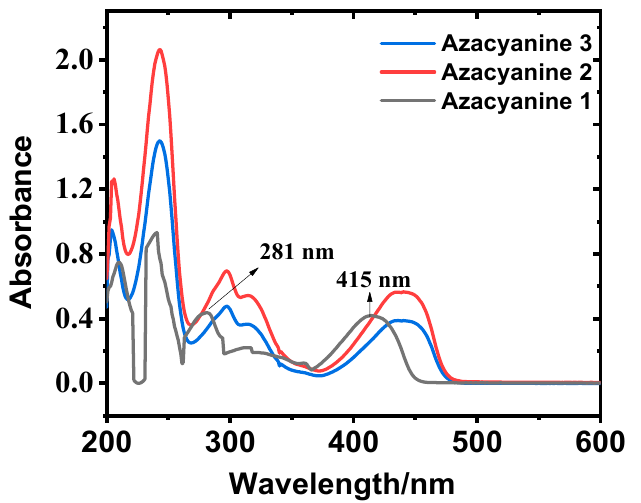
Figure 5. The UV-Vis spectra of the target azacyanine products: Azacyanine 1 (black); Azacyanine 2 (red); Azacyanine 3 (blue).